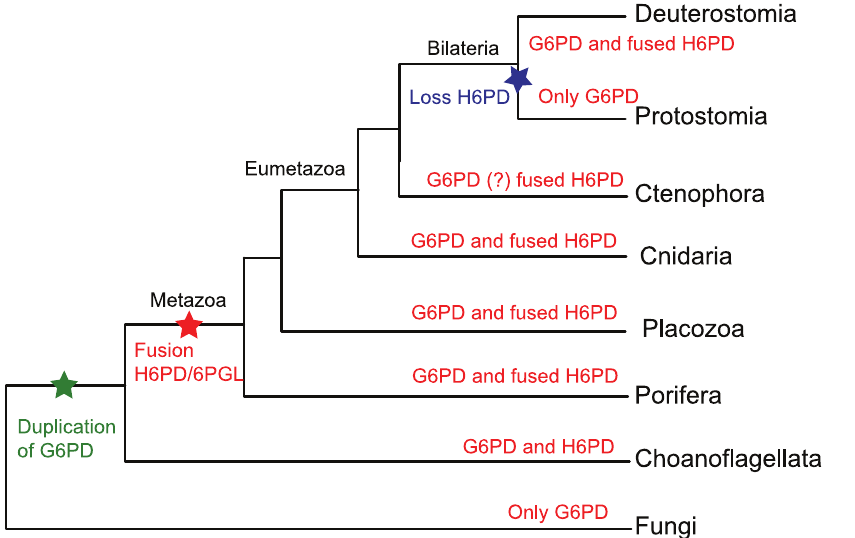
Figure 6. Phylogenetic tree of opisthokonts. Adapted from [34]. The tree shows the duplication of G6PD, leading to the presence of H6PD in an ancestor to metazoa and choanoflagellates (green star), and the subsequent fusion of H6PD to 6PGL in an ancestor of only Metazoa (red star). Protostomes subsequently lost their copy of H6PD (blue star) and Aves lost their copy of G6PD (not shown; see Figure 2).